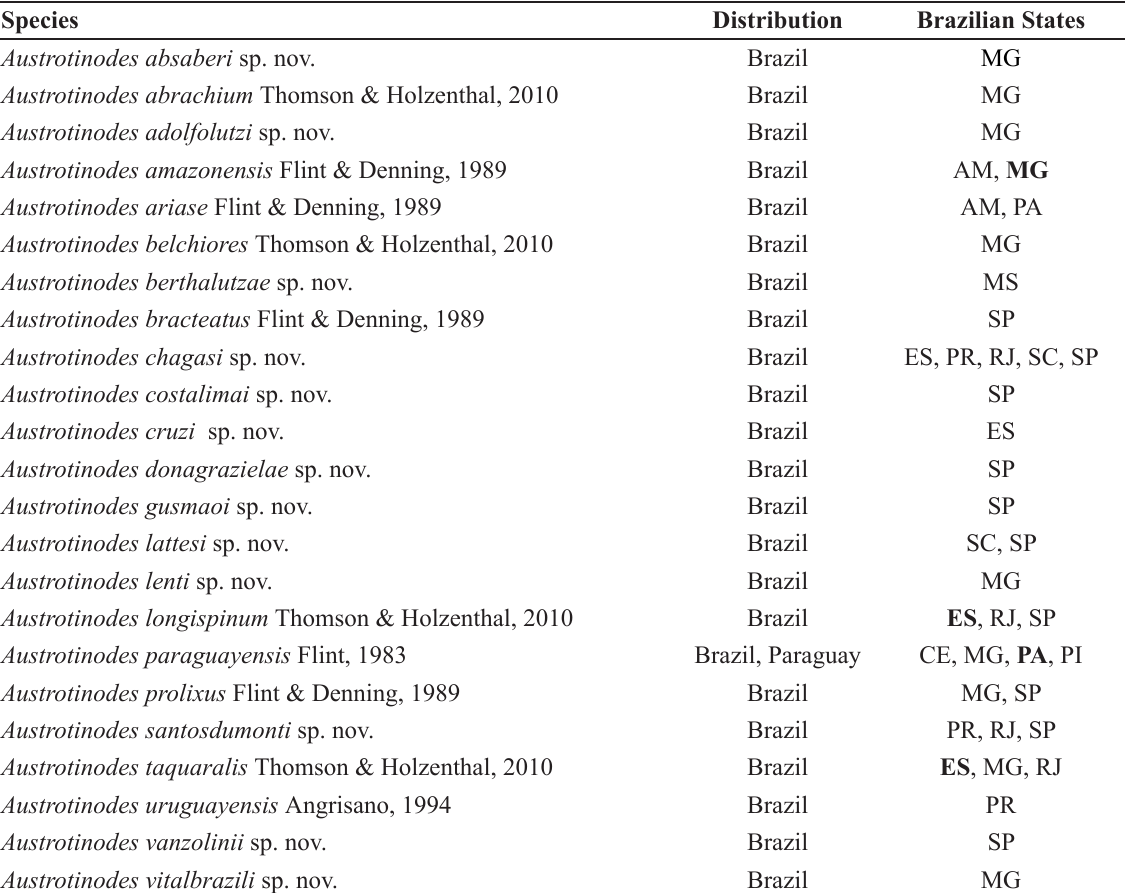
Table 1. Brazilian Austrotinodes . Codes for Brazilian states are as follows: Amazonas (AM), Ceará (CE), Espírito Santo (ES), Mato Grosso do Sul (MS), Minas Gerais (MG), Pará (PA), Paraná (PR), Piauí (PI), Rio de Janeiro (RJ), Santa Catarina (SC), and São Paulo (SP). Codes in bold represent new state